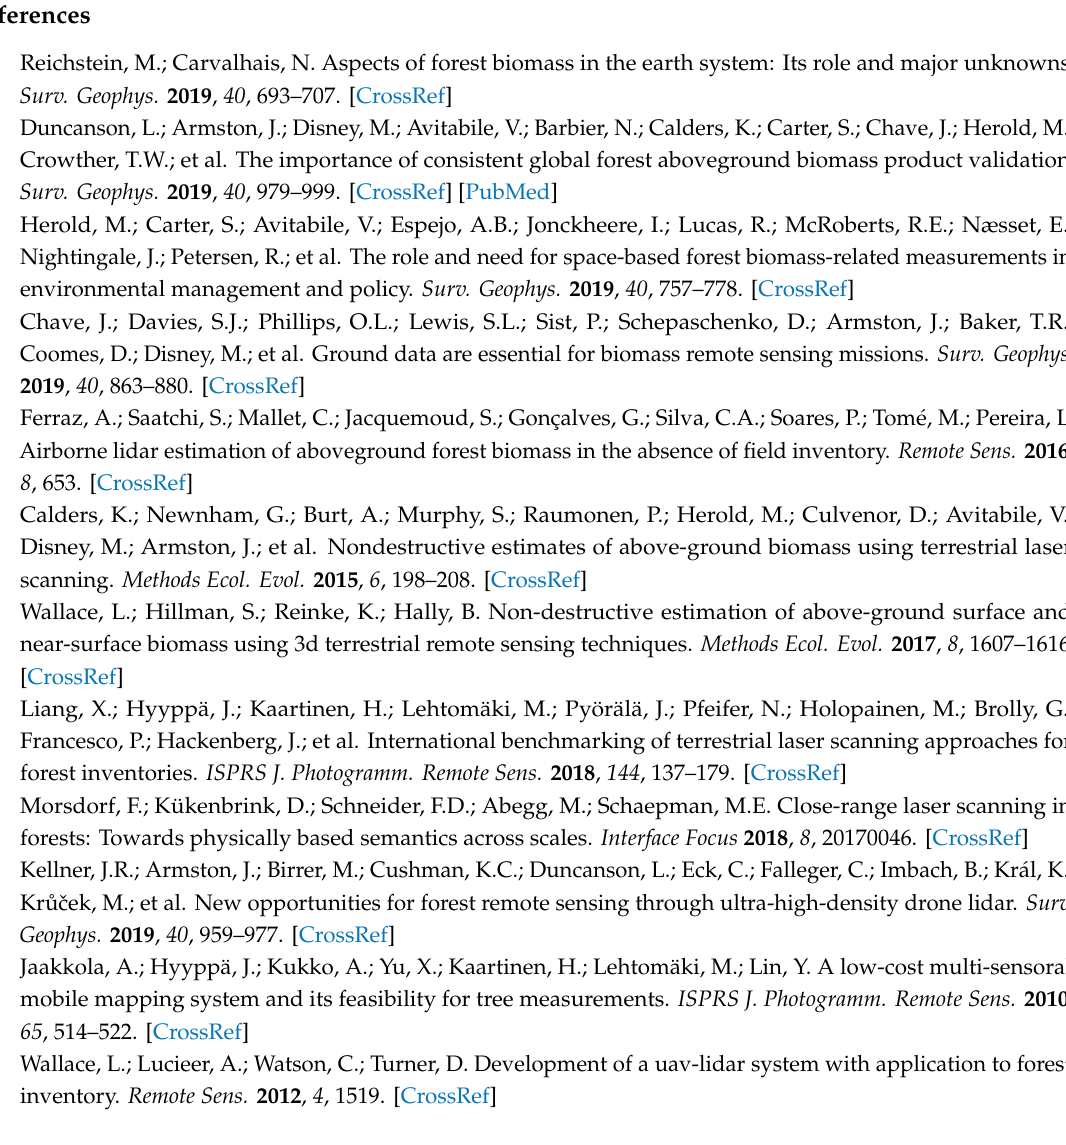
field survey and both estimates had similar precision. stands and smallest in dense birch or spruce